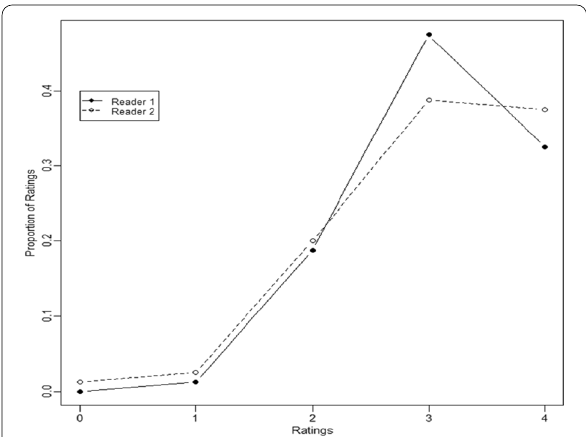
Fig. 1 Distribution of ratings for reader 1 and reader 2